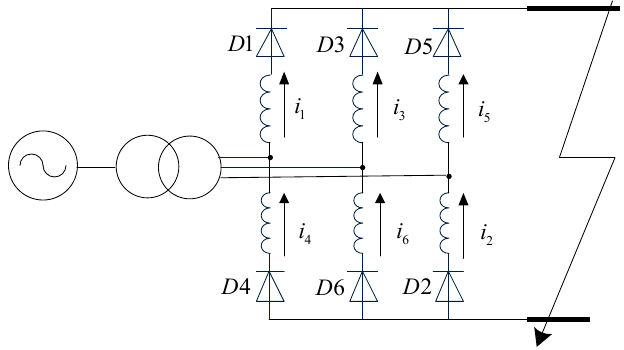
Figure 2. Equivalent diagram of blocked MMC (multi ‐ modular converter).